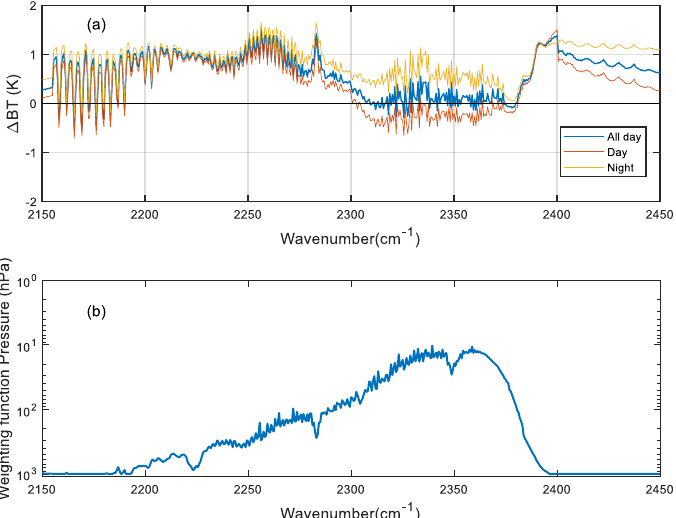
Figure 15. ( a ) The spectral dependence of BT differences ( ∆ BT C2-CrIS ) between CRTM-simulated STAR COSMIC-2 BT and NOAA-20 CrIS measurements. ( b ) Peak weighting function position (in hPa) over the corresponding CrIS spectral channels.